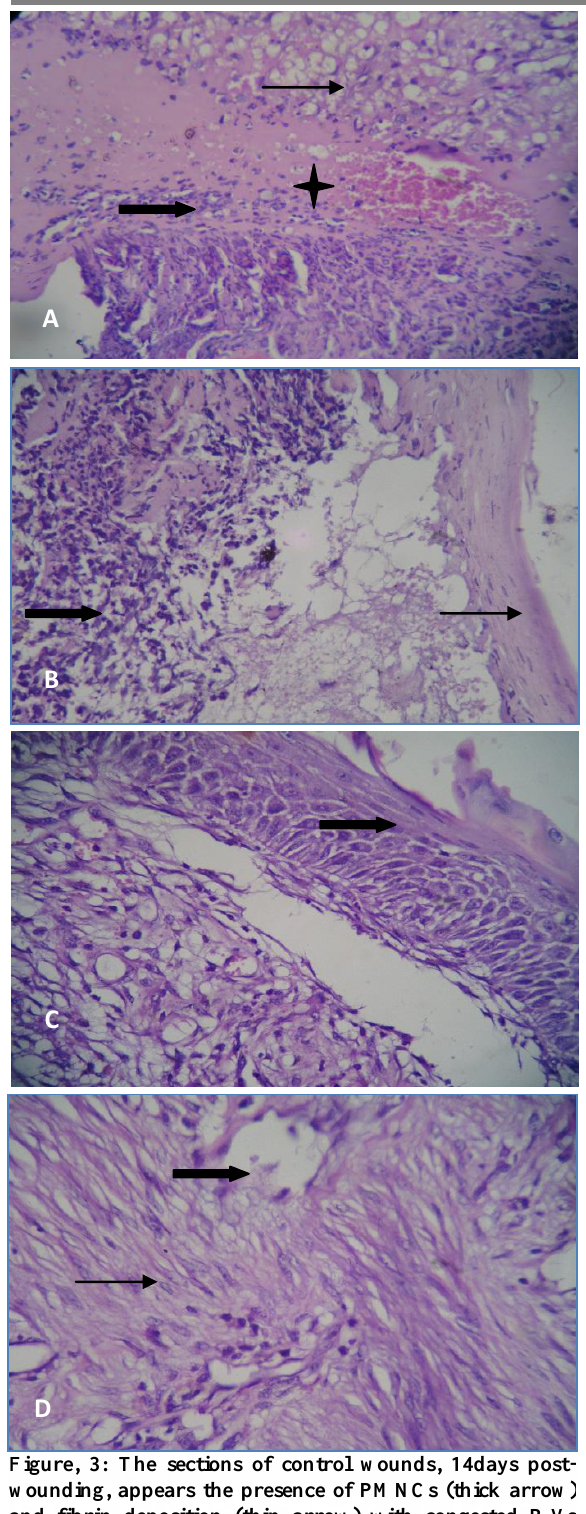
Figure, 3: The sections of control wounds, 14days post- wounding, appears the presence of PMNCs (thick arrow) and fibrin deposition (thin arrow) with congested B.Vs together with minimal re-epithelization (star) (A), with newly formed thin flatted epithelium consist of developed stratum cornium (thin arrow) accompanies in other section with intense PMNCs aggregation (thick arrow) (B). The sections of treated wounds, 14days post-wounding, shows the presence of moderate to complete re- epithelization and the incision lined with mature newly epithelial consist of stratified sequmous epithelial cells (thick arrow) developed over the highly cellular granulation tissue (thin arrow) (C), and moderate number of B.Vs containing polymorphous leukocytes (thick arrow) with young fibroblasts producing collagen fibers (thin arrows) (D) (H and E